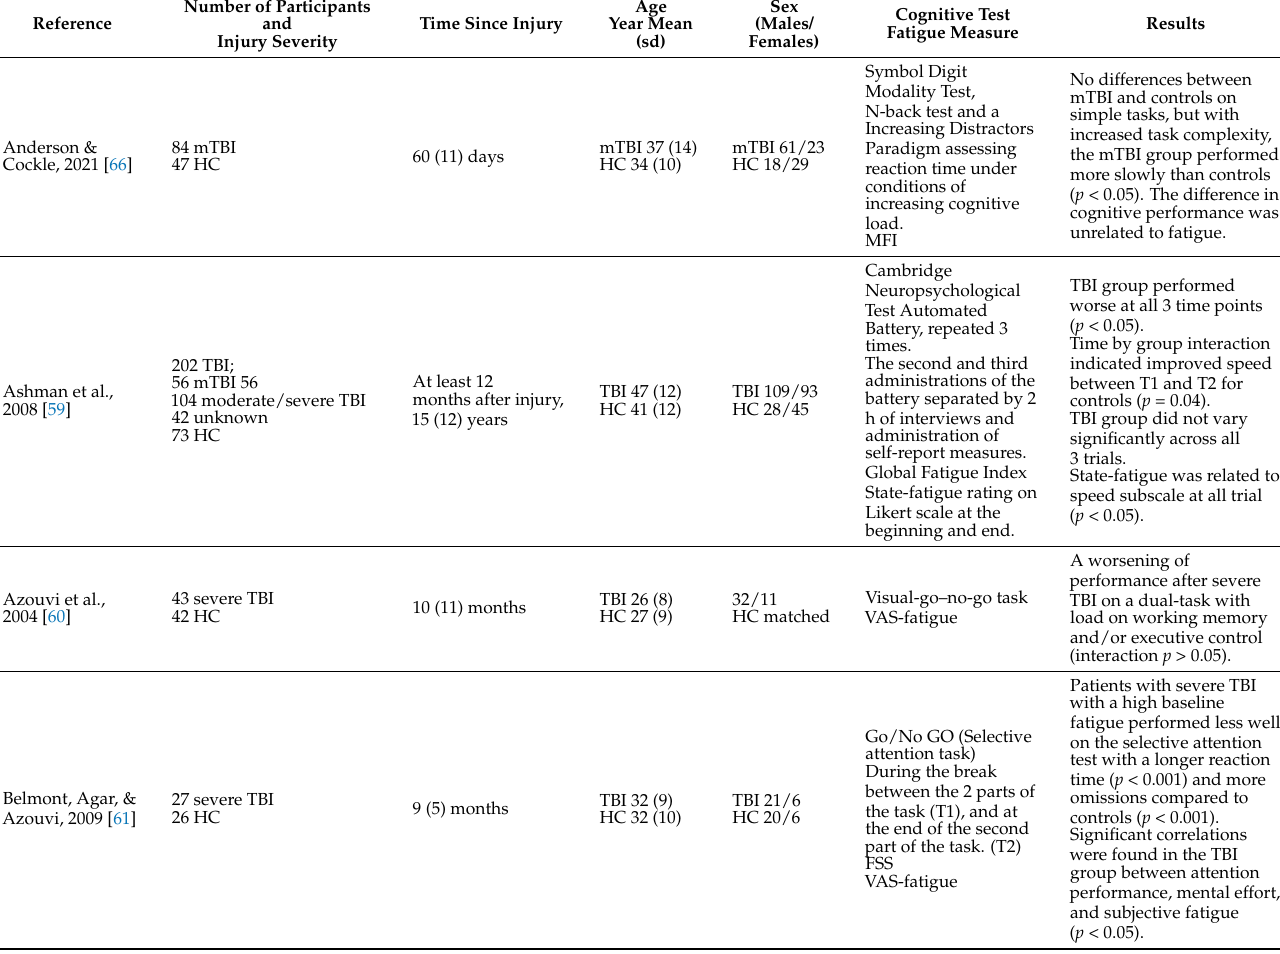
Table 1. Research relating fatigue in adults after TBI to cognitive function. Summary of study characteristics, including details on study sample, methods, and